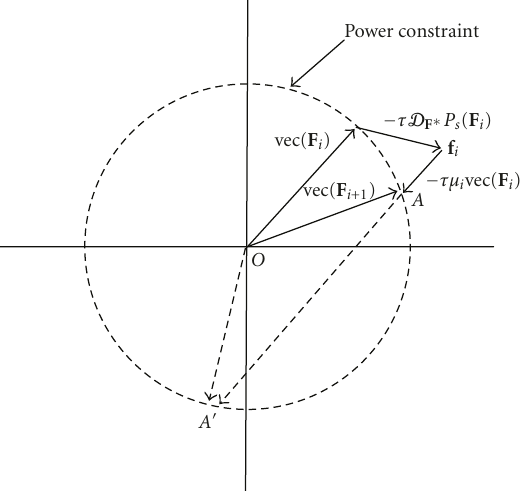
Figure 8: A graphical interpretation of the solutions of (28). The gradient vector D F ∗ P s ( F i ) + μ i vec( F i ) depends on μ i . Provided that the step-size τ is small enough, (28) yields two possible values for μ i for which the updated precoder F i +1 satisfies the power constraint. The two possible solutions for the updated precoder are given by OA and OA (cid:11) . The use of smaller μ i yields the desired updated precoder OA for which the gradient descent